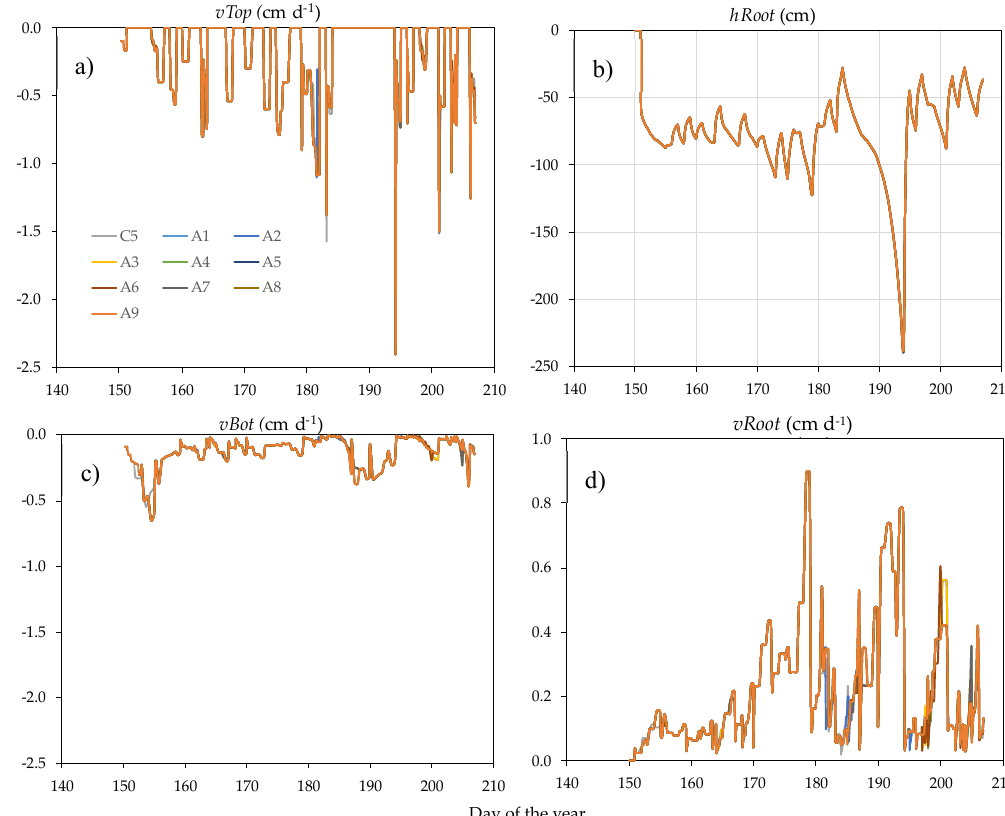
Figure 12. Dynamic of daily rates of soil infiltration ( a ), percolation ( c ), water uptake ( d ), and pressure head of soil root volume ( b ) under the nine Ks scenarios.